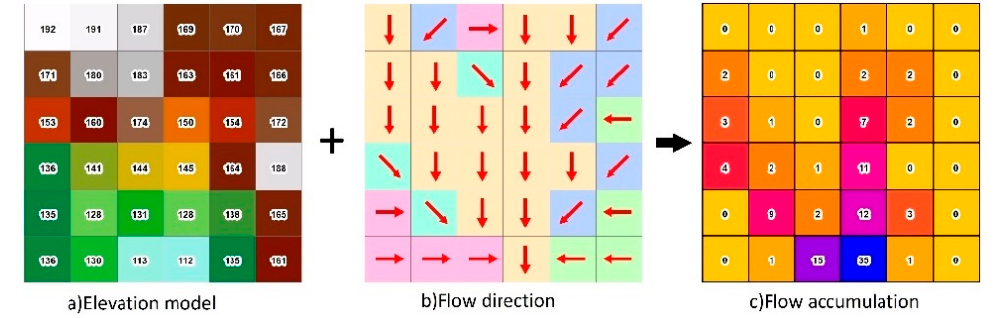
Figure 3. Flow Accumulation [25].